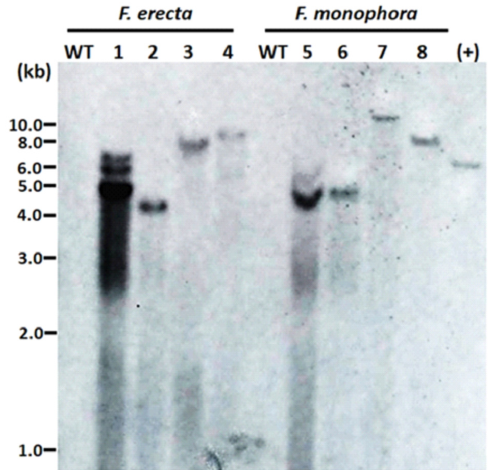
Figure 3. Integrations of T-DNA containing the hph gene into the genome of the Fonsecaea erecta and Fonsecaea monophora after Agrobacterium -mediated transformation with pAD1625 (1, 2, 5, 6) or pCAMdsRED (3, 4, 7, 8). A total of 38 µg of genomic DNA was digested with BglII, and 0.6kb digoxigenin-labelled hph was used as probe. The genomic DNA from the wild-type strain of F. erecta (CBS 125763) and F. monophora (CBS 269.37) were used as the untransformed negative control (WT), while the HindIII linearized pAN7.1 was the positive control.